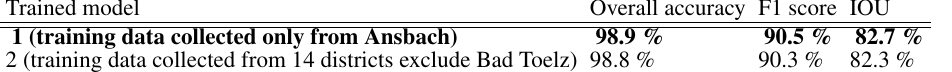
Table 2. Accuracy of two different trained models evaluated in Ansbach